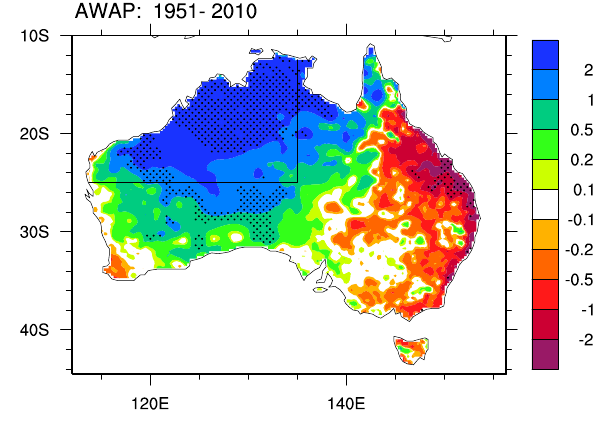
Fig. 1. Observed DJFM rainfall trends from AWAP (mmday − 1 century − 1 ) for 1951–2010. Stippled trends are significant at 5% based on a t-test, after adjusting for the serial correlation. The area enclosed by the black lines (land only) denotes the region referred to as north-western Australia in some of the following